Question: Give a one-sentence summary of this figure.
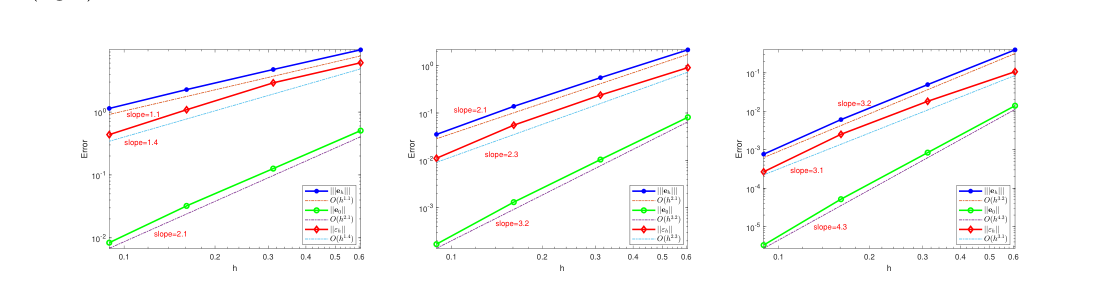
Answer: The numerical results for Example 7.2 on curved quadrilateral meshes with k = 1 (left), 2 (middle), 3 (right).